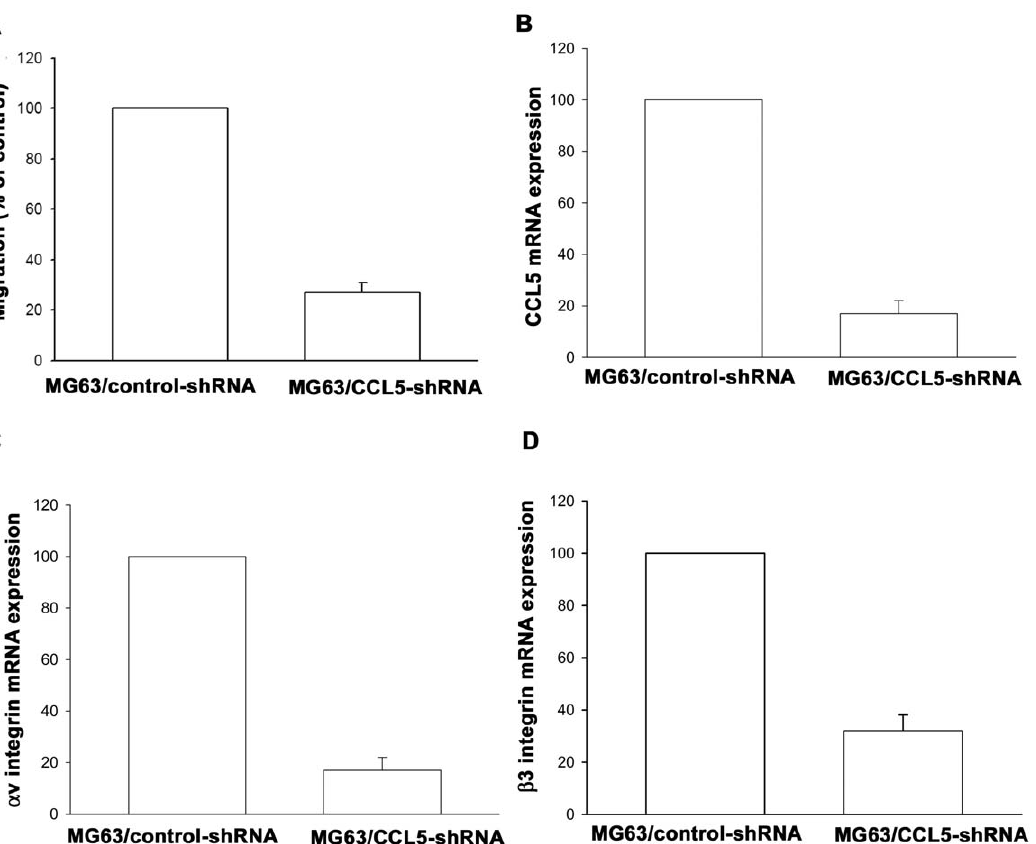
Figure 6. Knockdown of CCL5 inhibited the migratory ability in osteosarcoma cells. (A) The in vitro migration activity of MG63/control- shRNA and MG63/CCL5-shRNA cells was measured with the Transwell. (B–D) The mRNA levels of CCL5, a v and b 3 integrin in MG63/control-shRNA and MG63/CCL5-shRNA cells was examined by qPCR. Results are expressed as the mean 6 S.E.